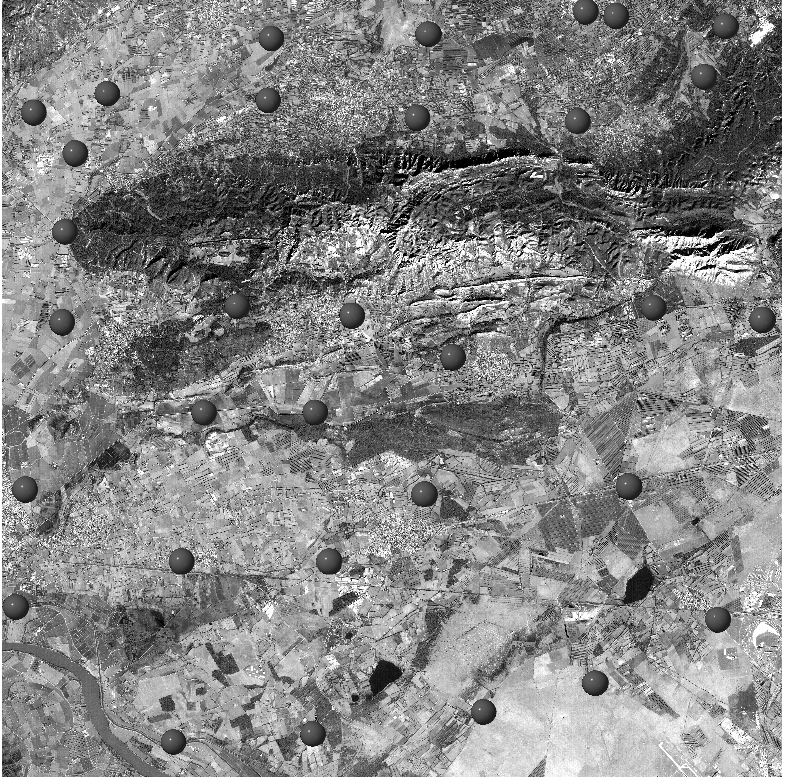
Figure 6. Cartosat-1 Aft image collected over Mausanne les Alpilles (France) with superimposed the high-precision GPS measured GCPs provided by the Principal- Investigator European Commission-Joint Research Centre.